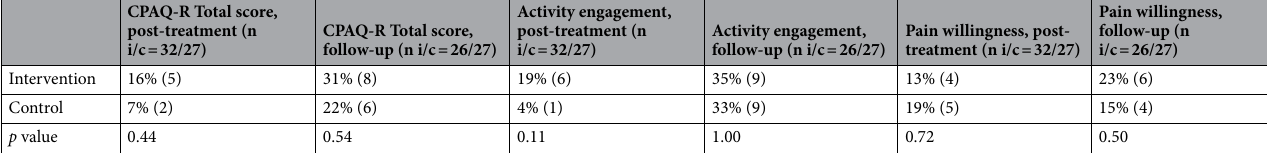
Table 6. Percentage of clinical meaningful change measured with reliable change index (RCI) for